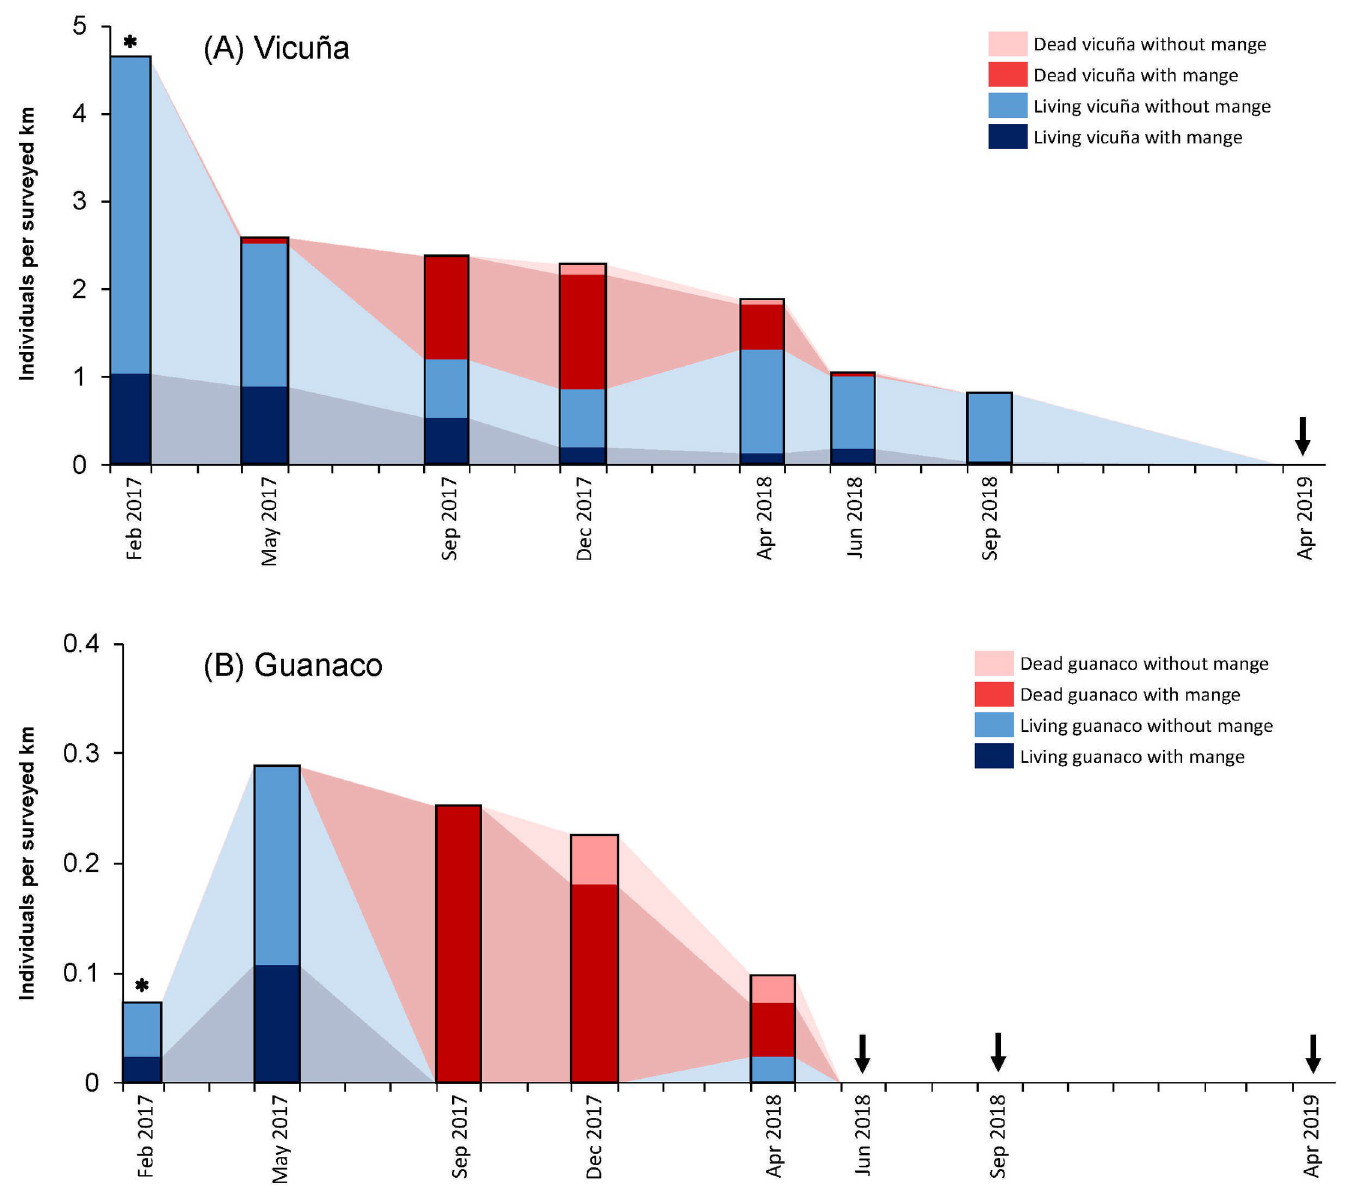
Fig 3. Time series of the number of living camelids observed in transect surveys and opportunistically collected carcasses with and without mange at San Guillermo National Park, February 2017 –April 2019. Asterisks indicate months when carcasses were not evaluated. Arrows represent field surveys where no individuals were recorded. Light shaded areas between bars are used to highlight the relative changes between field surveys (no data was collected in these intervals).